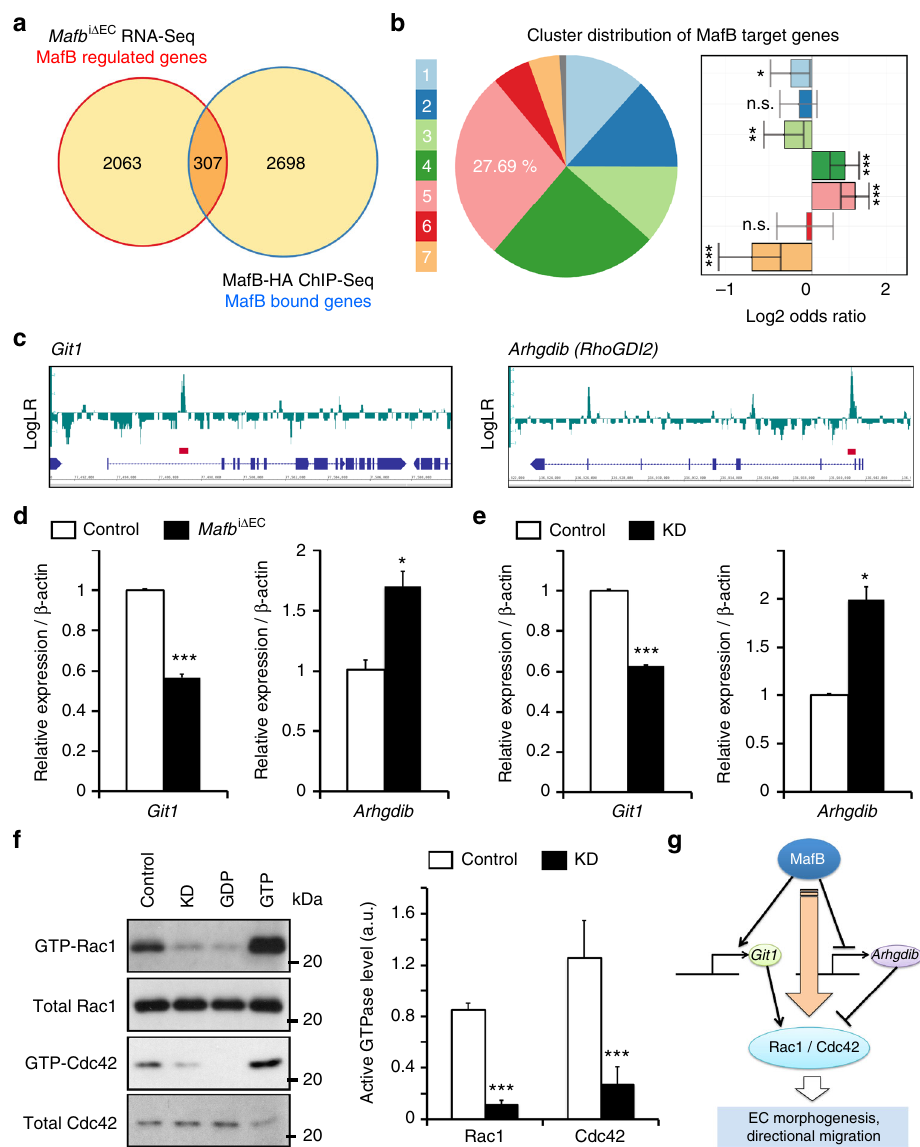
Fig. 7 Direct target genes of MafB for the regulation of EC behavior. a Venn diagram of putative MafB-regulated genes identi fi ed by P6 retinal EC RNA-Seq and MafB ChIP-Seq. b Association between MafB target genes and retinal clusters of differential gene expression. Only genes overlapping in a are used for this analysis. (Fisher ’ s exact test with FDR adjustment for multiple testing; ns, not signi fi cant; * q -value < 0.05; ** q -value < 0.01; *** q -value < 0.001). c MafB ChIP-Seq tracks of Git1 and Arhgdib genes; red bars , MafB peaks called by HOMER. d , e RT-qPCR analysis of Git1 and Arhgdib in P6 retinal ECs ( d ) or MS1 mouse EC lines ( e ). n = 3, * P < 0.05, *** P < 0.0001; unpaired Student ’ s t -test, Error bars represent mean + s.e.m. f Precipitation and western blot detection of active, GTP-bound Rac1 and Cdc42 in Mafb knockdown (KD) MS1 ECs in vitro. Graph shows quanti fi cation by densitometric analysis. Active Rac1/Cdc42 levels were normalized with the total Rac1/Cdc42 in whole cell lysates. GDP and GTP demonstrate negative and positive controls of active Rac1/Cdc42 levels, respectively. n = 3, Error bars represent mean + s.d., *** P < 0.0001; unpaired Student ’ s t -test. g Schematic model outlining the transcriptional regulation of EC behavior by MafB. MafB regulates expression of Git1 and Arhgdib simultaneously but differentially, which facilitates Rac1 and